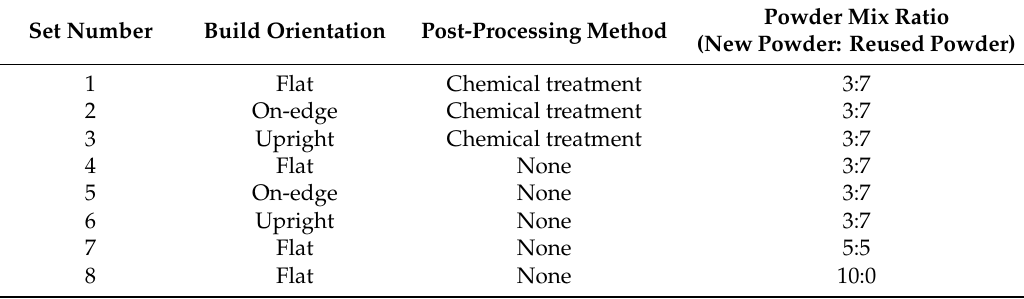
Table 3. Eight sets of specimens printed with di ff erent processing parameters.